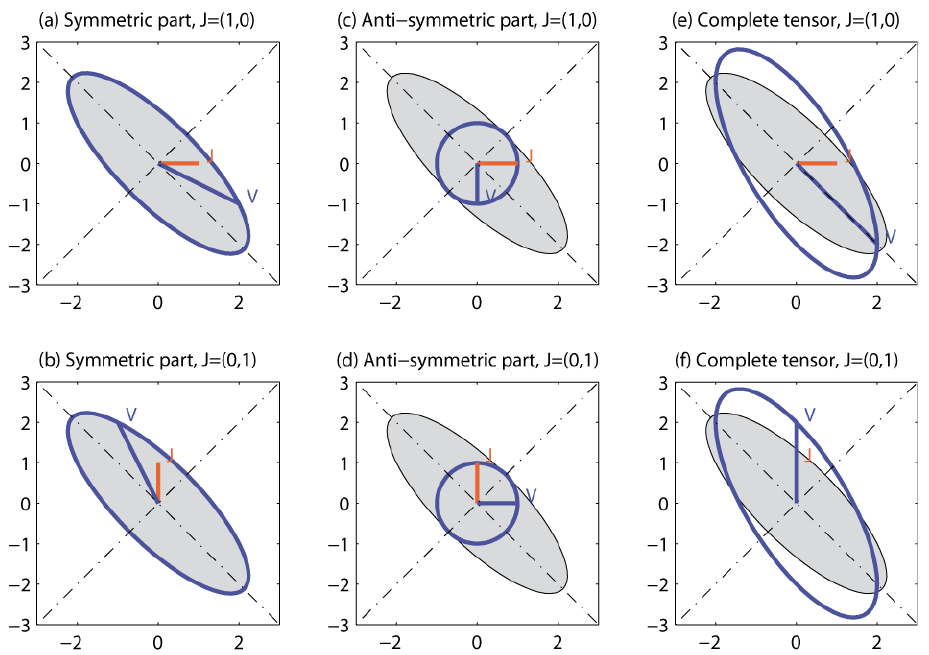
Figure 3. ( a – f ). ( a , b ): Schematic illustration of symmetric behavior, illustrating the symmetric contribution for a given hydraulic gradient J (orange arrow). The resulting Darcy velocity vector V is shown as a solid blue arrow. Here, the principal system is at an angle θ = − π /4 with respect to the reference frame. ( c , d ): Schematic illustration of anti-symmetric behavior, illustrating the antisymmetric contribution for a given hydraulic gradient J (orange arrow). The Darcy velocity vector V is shown as a solid blue arrow. The orientation of the principal system ( θ ) plays no role in this antisymmetric component of the flow. The antisymmetric deflection is always orthogonal (90 degrees). ( e , f ): Schematic illustration of the complete behavior of an anti-symmetric and inclined permeability tensor K = K S + K A for a given hydraulic gradient J (orange arrow, visible in ( e ), but hidden behind V in ( f )). The resulting Darcy velocity vector V is shown as a solid blue arrow. The principal system of the symmetric part K S is at an angle θ = − π /4 with respect to the reference frame. The antisymmetric part ( K A ) exerts an orthogonal deflection (always at 90 degrees), which does not depend on the θ